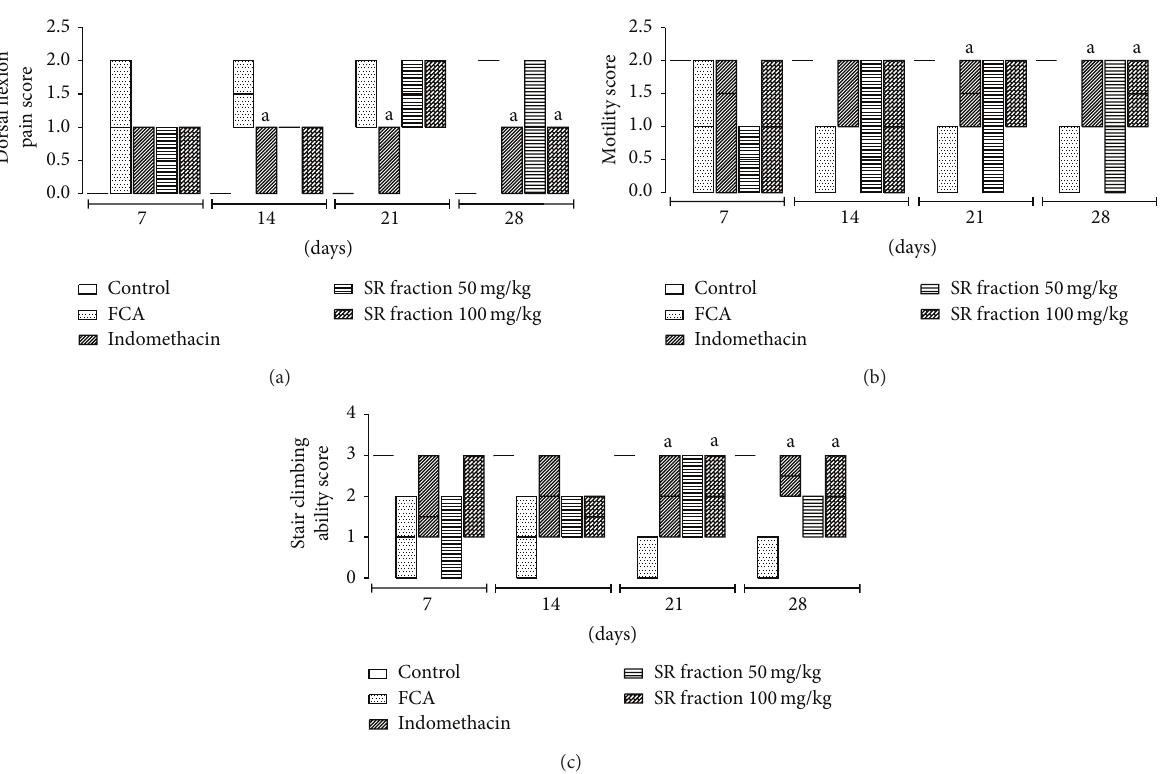
Figure 2: Effect of saponin rich (SR) fraction on inflammatory hyperalgesia in arthritic rats. The scores of (a) dorsal flexion pain, (b) motility, and (c) stair climbing ability is illustrated as box plots where bold line represents median values ( 𝑛 = 6 ) and boxes represent interquartile ranges (25th and 75th percentiles), a 𝑃 < 0.05 compared with FCA